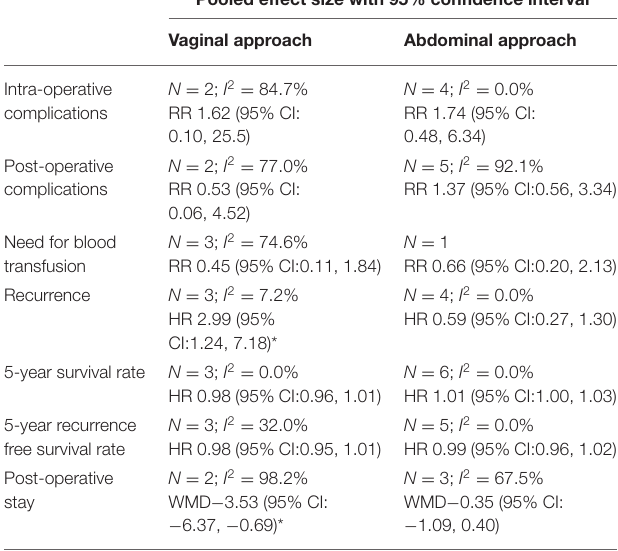
TABLE 1 | Subgroup analysis based on the approach of trachelectomy (vaginal and abdominal). Pooled effect size with 95% confidence interval Vaginal